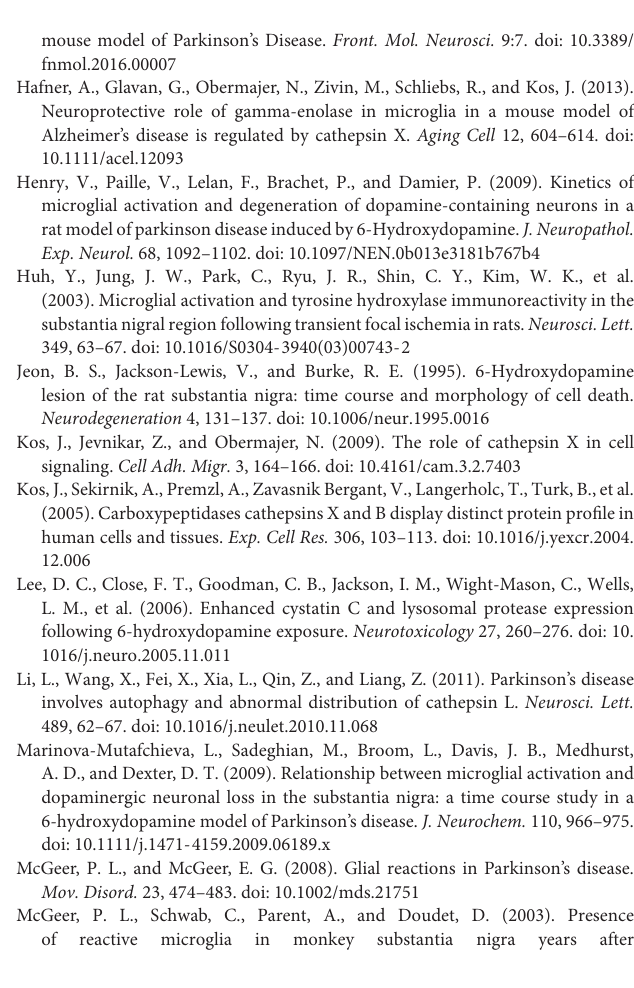
FIGURE S1 | Expression of TH and cathepsin X protein in the striatum after 6-OHDA injection. Representative immunohistochemical images for TH (A) and cathepsin X (B) in coronal midbrain sections of striatum from the 12, 24, and 48 h time-points after 6-OHDA-induced lesion. Scale bars = 50 µ m. FIGURE S2 | Lysosomal localization of cathepsin X in the 6-OHDA-induced nigrostriatal lesion. Representative images of double immunofluorescent staining of lysosomal marker LAMP1 (green fluorescence) and cathepsin X (red fluorescence) in the ipsilateral SNc after 6-OHDA injection. Nuclei were counterstained with DAPI (blue). Cathepsin X was strongly localized in LAMP1-positive vesicles in the ipsilateral SNc after 12 h (A) , 24 h (B) , and 48 h (C) of 6-OHDA injection, as indicated by white arrows. For each condition, a group of 4 animals ( n = 4) was analyzed and four sections of the SNc region of each animal were analyzed. Scale bars = 50 µ m. FIGURE S3 | Immunohistochemical analysis of microglia activation in the SNc after 6-OHDA injection. Representative images of double immunofluorescence staining of the microglial marker OX-6 (green fluorescence) and cathepsin X (red fluorescence) in the ipsilateral SNc at 24 h (A) and 48 h (B) after 6-OHDA-injection. Nuclei were counterstained with DAPI (blue). Scale bar = 50 µ